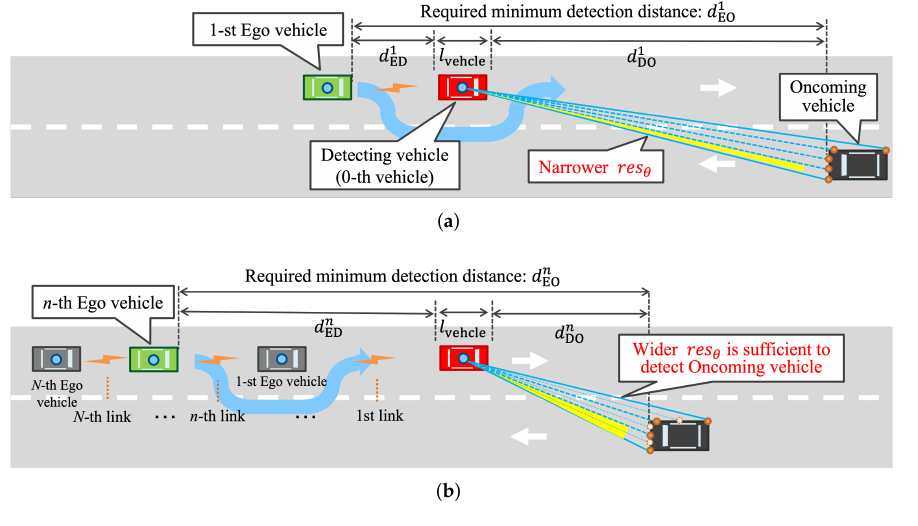
Figure 1. MmWave V2V relays with extended sensors in overtaking traffic situation. ( a ) Single-hop case: Oncoming vehicle is far from Detecting vehicle, which requires a higher data rate for LiDAR with narrower (original) resolution. ( b ) Multi-hop case: the oncoming vehicle is closer to the Detecting vehicle where a lower data rate is sufficient for LiDAR with wider (down sampled)